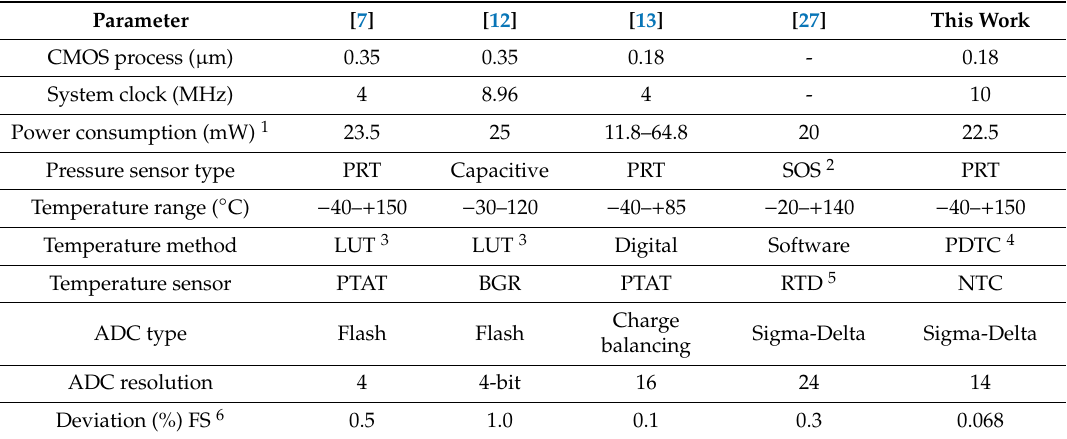
Table 3. Temperature-compensation performance comparison.